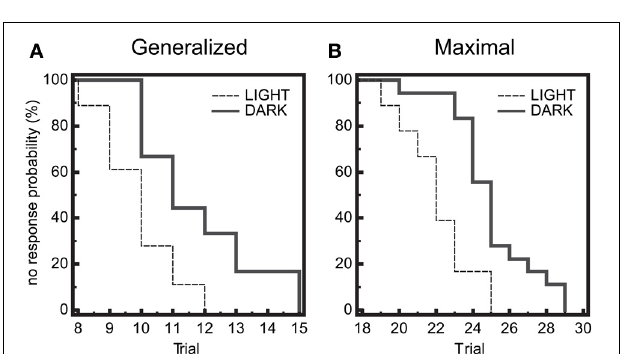
FIGURE 2 | Diurnal effects on seizure threshold. Endpoints of electroshock-induced seizures for the three light-period groups (ZT1, 5, 9) and dark-period groups (ZT15, 19, 23) show differential percent probability of no response in both (A) generalized (GEST) and (B) maximal (MEST) electroshock seizure threshold, with greater resistance in the dark-phase (solid line) compared to the light phase (dashed line). (A) Median trial number to reach GEST: Light = 10, Dark = 11; Logrank test: Chi-square 11.31, P = 0 . 0008; N = 18 per group. (B) Median trial number to reach MEST: Light = 22, Dark = 25; Logrank test: Chi-square 13.96, P = 0 . 0002; N = 18 per